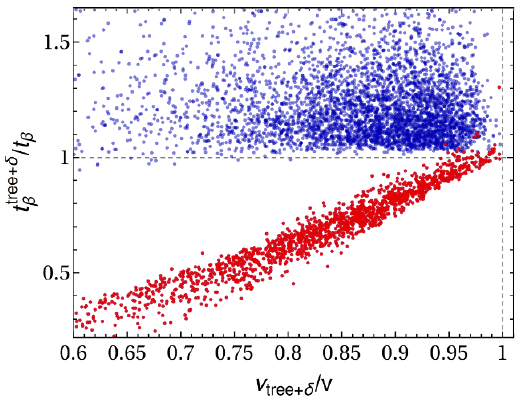
Figure 5 . Variation of t (cid:12) and v when shifting the quadratic parameters m 2 blue (red) points represent (non-)regular